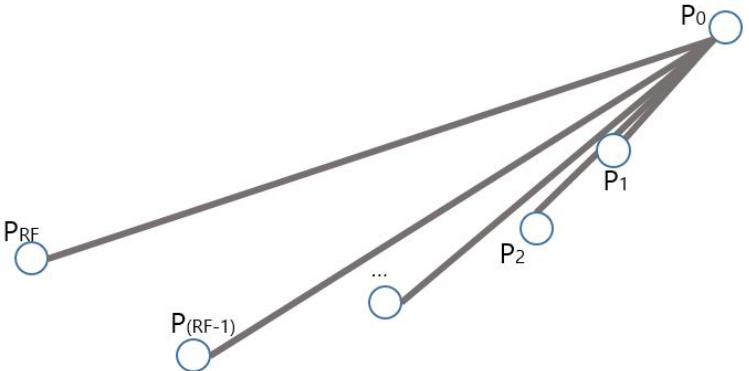
Figure 6. Locus of left elbow point (which is represented as a circle), as much as before RecentFrame (RF) from the Current Frame. RecentFrame is the frame depth variable, which is 5 in the current figure. This figure is from the shoulder area of Figure